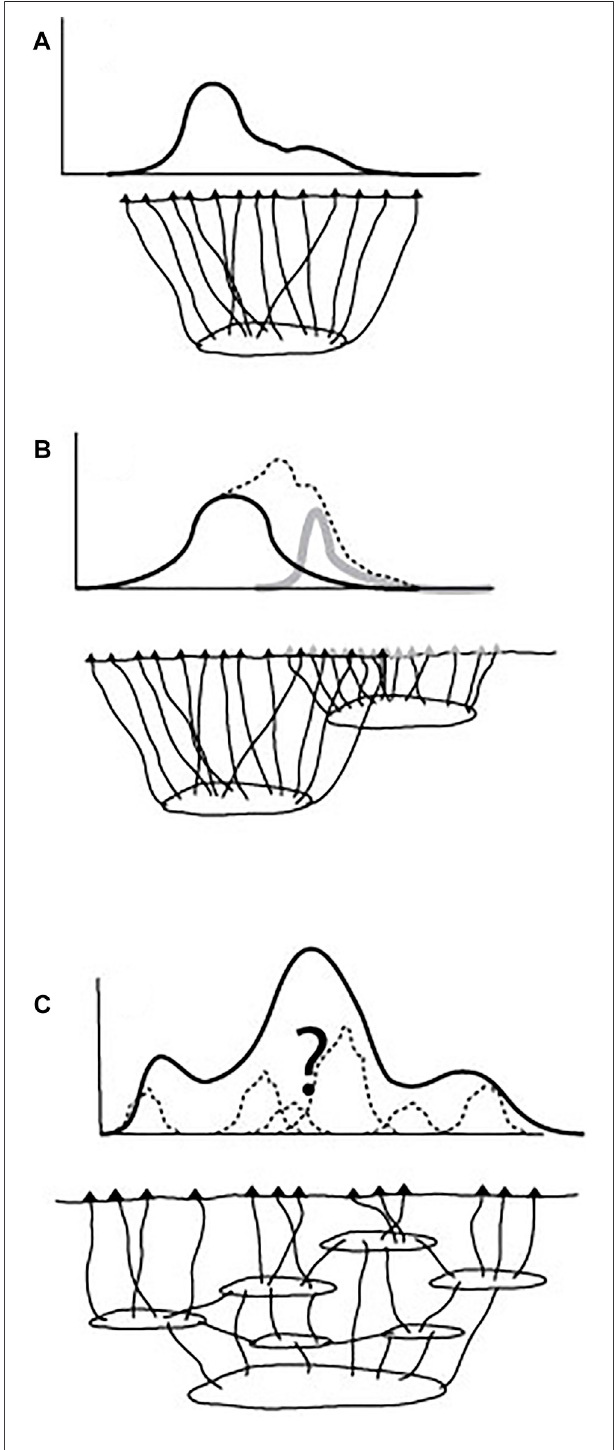
FIGURE 1 | Cartoons of three possible scenarios in a region of distributed volcanism and their associated probability density distribution (PDF). In all three scenarios the upper part shows alternative PDFs (solid, dashed or grey lines) and the lower diagram show vents (triangles), zones of magma storage (ellipses) and conduits allowing the vertical transport ofmagma(lines).ThePDFscouldbenormalizedornot,sotheverticalaxesare